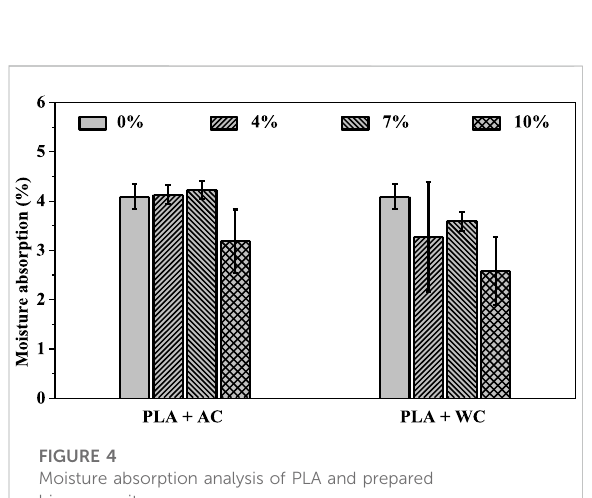
FIGURE 4 Moisture absorption analysis of PLA and prepared biocomposites.